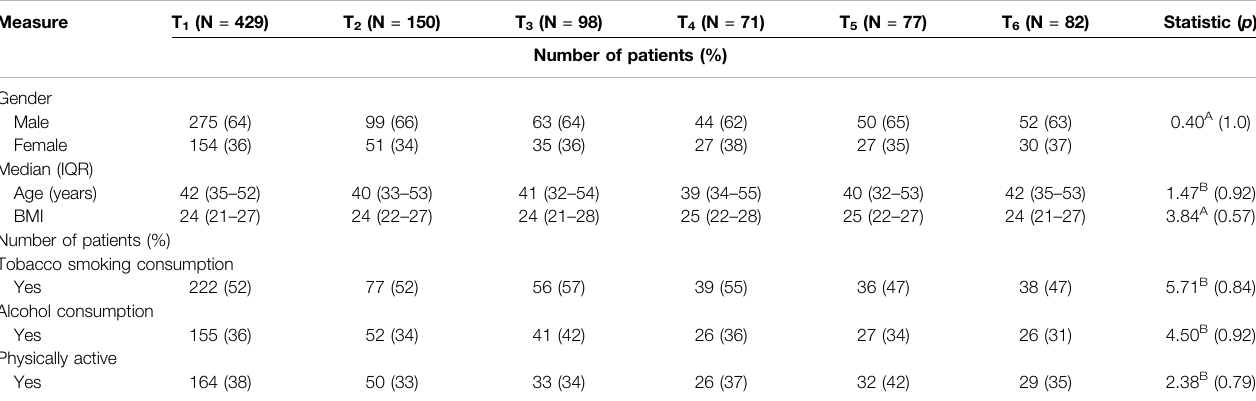
TABLE 1 | Demographic characteristics of the study sample at one month intervals within a six-month